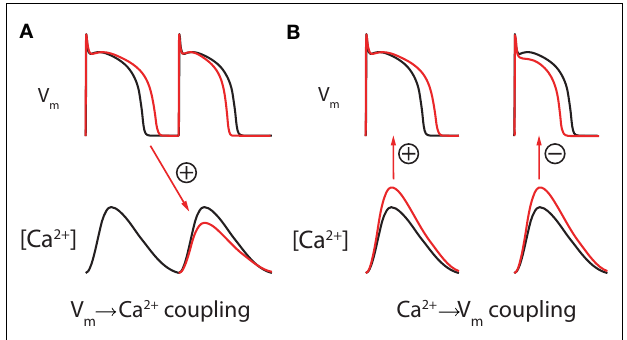
FIGURE 9 | Bidirectional coupling ofV m and Ca 2 + . (A) During static pacing,V m → Ca 2 + coupling is assumed to be positive due to graded release (as shown). An increase in the preceding APD leads to a decrease in the subsequent Ca 2 + transient (due to a shortening of the diastolic interval), and vice versa. Note that this change in DI will also have an APD restitution mediated effect on the subsequent APD (in this case, shortening it). (B) Ca 2 + → V m coupling can be either positive (left) or (right), dependent on species, cell type, and temperature. Adapted from Gaeta et al.